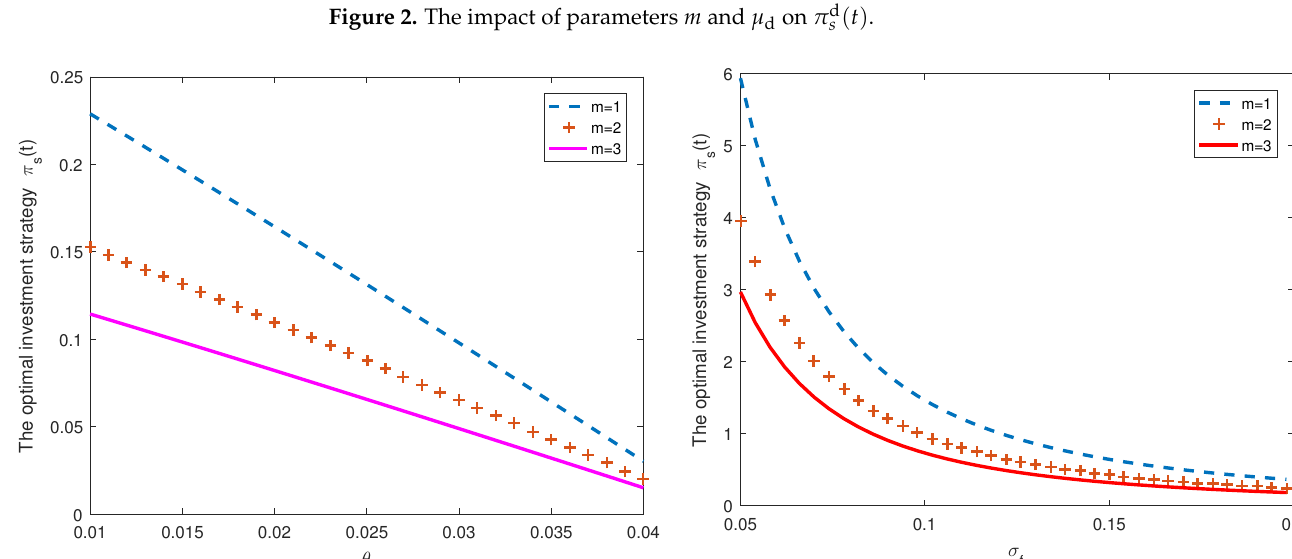
Figure 3. The impact of parameters m , θ and σ f on π s ( t )